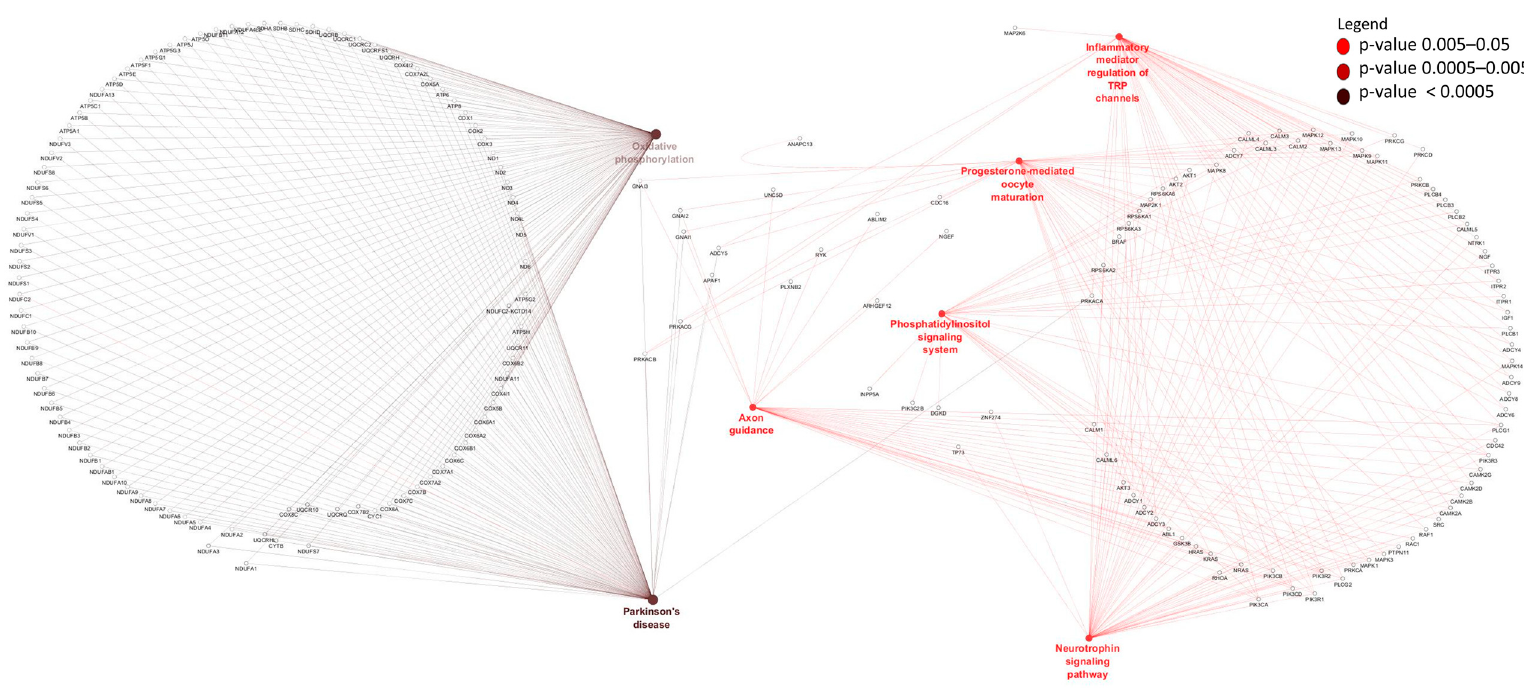
Figure 6. Kyoto Enciclopedia of Genes and Genomes pathways enriched for ileum lncRNA potential cis target genes. TRP: Transient receptor potential.